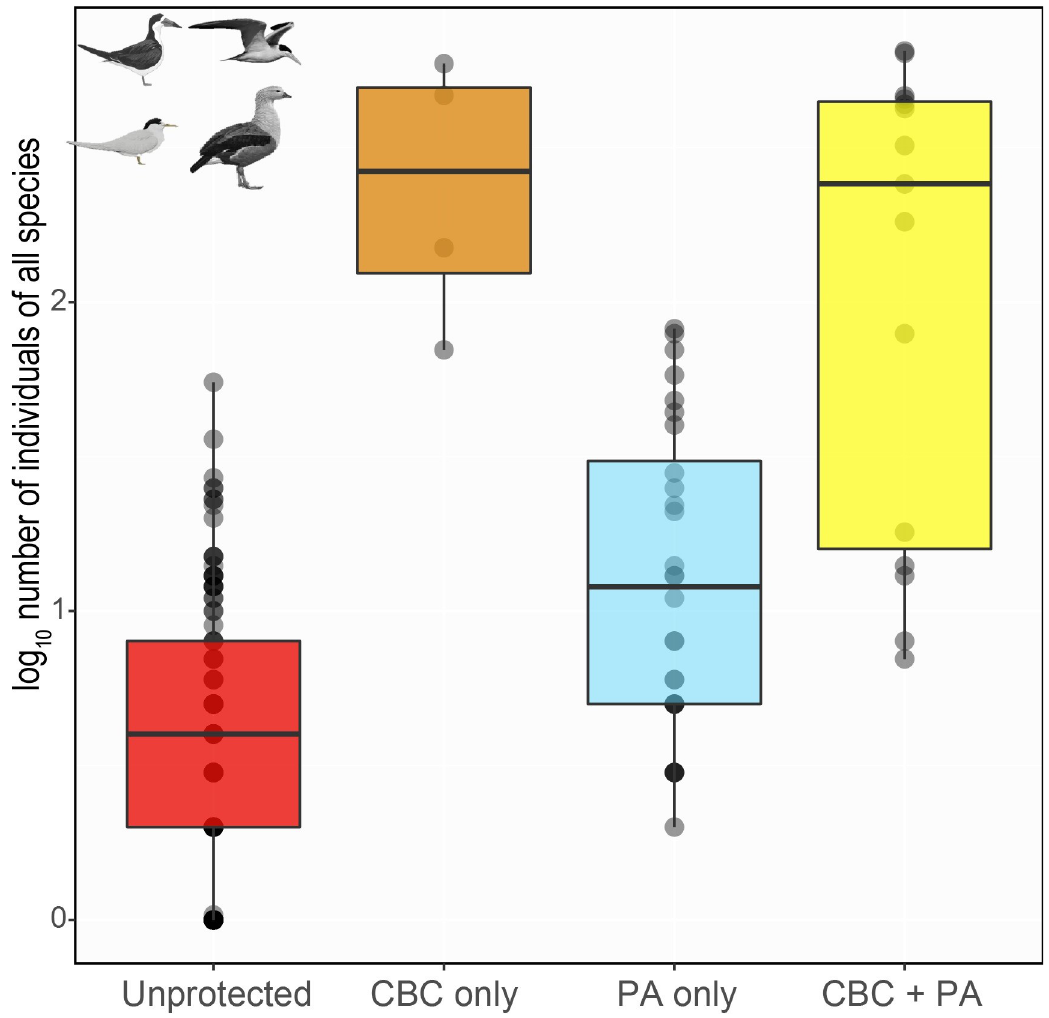
Fig 2. Box plot showing the total number of waterbird individuals under different protection regimes. Red, orange, blue and yellow boxes represent beaches that are unprotected, under Community-Based Conservation but outside Protected Areas (CBC- only), inside a PA but without CBC (PA-only), and under CBC inside a PA (CBC + PA), respectively.